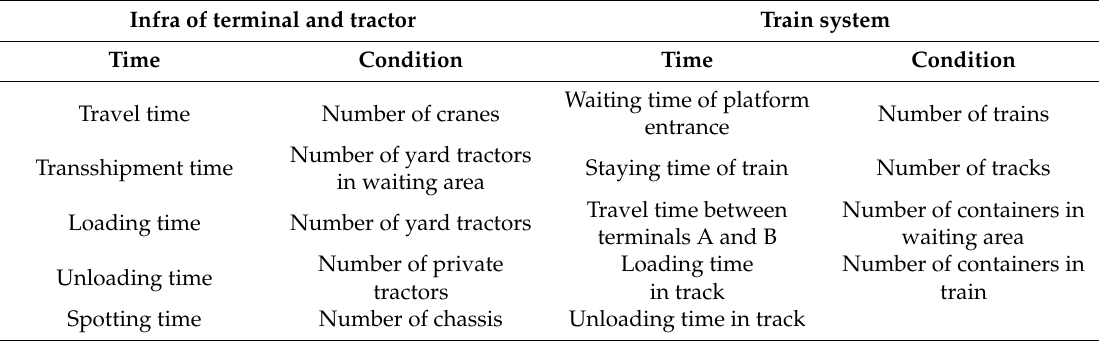
Table 1. Indices for the intermodal automated freight transport system simulator.